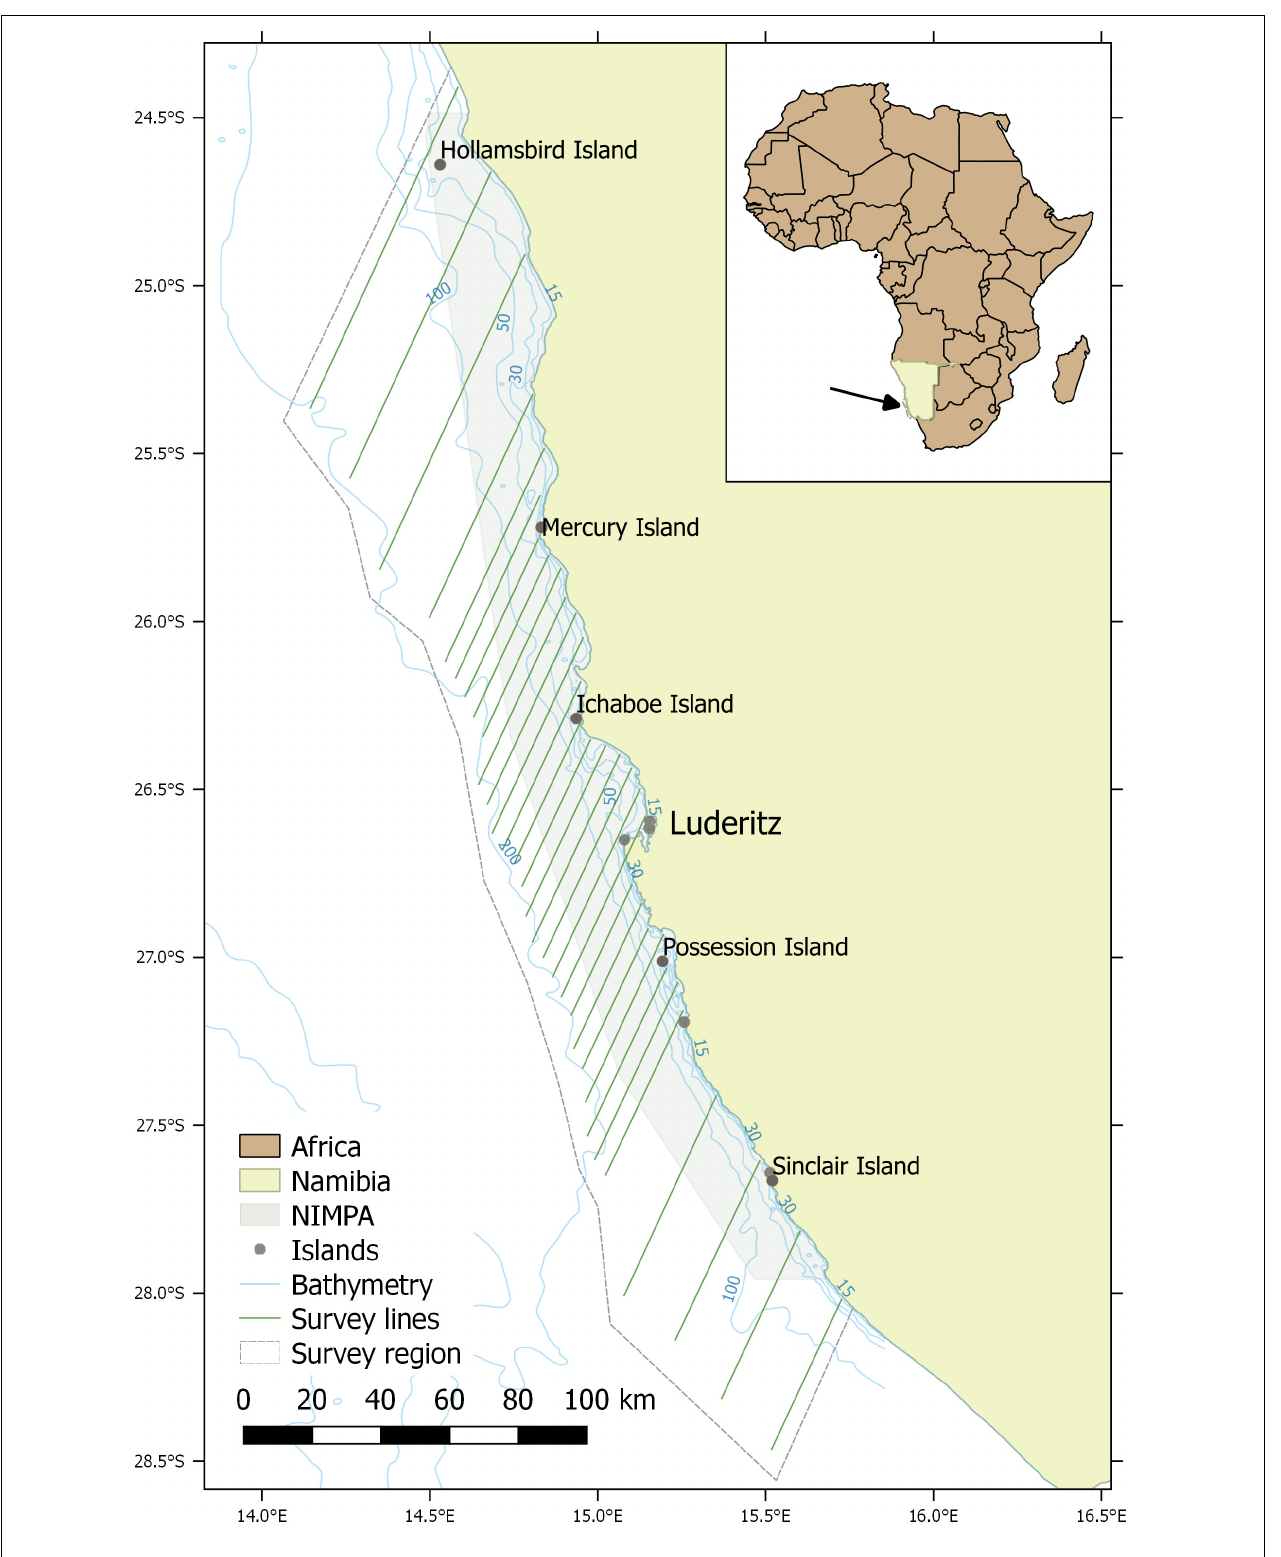
FIGURE 1 | Systematic parallel line transect survey design of the Namibian Islands’ Marine Protected Area (NIMPA) and its surrounding area located along the southern coast of Namibia. The town of Lüderitz and key islands within the MPA are indicated. The four northernmost survey lines represent the northern stratum and the four southernmost lines represent the southern stratum. All lines in between represent the central stratum.